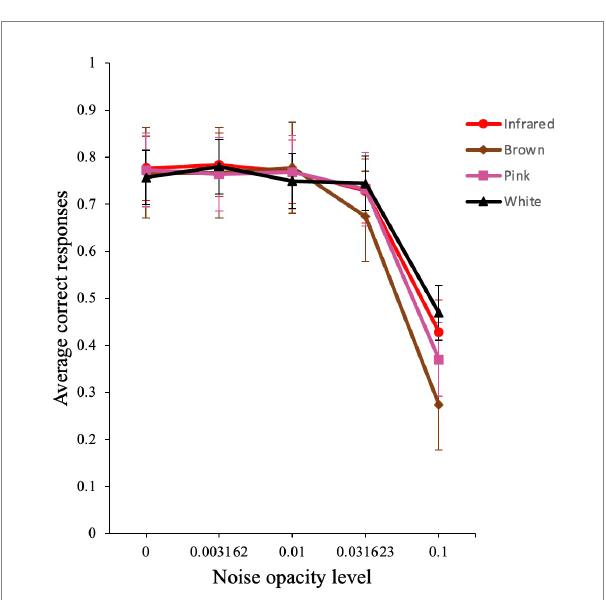
FIGURE 7 Average performance of participants in the visual detection task. Raw average accuracy versus noise level plot for infrared, brown, pink, and white noise. Error bars show standard errors of the